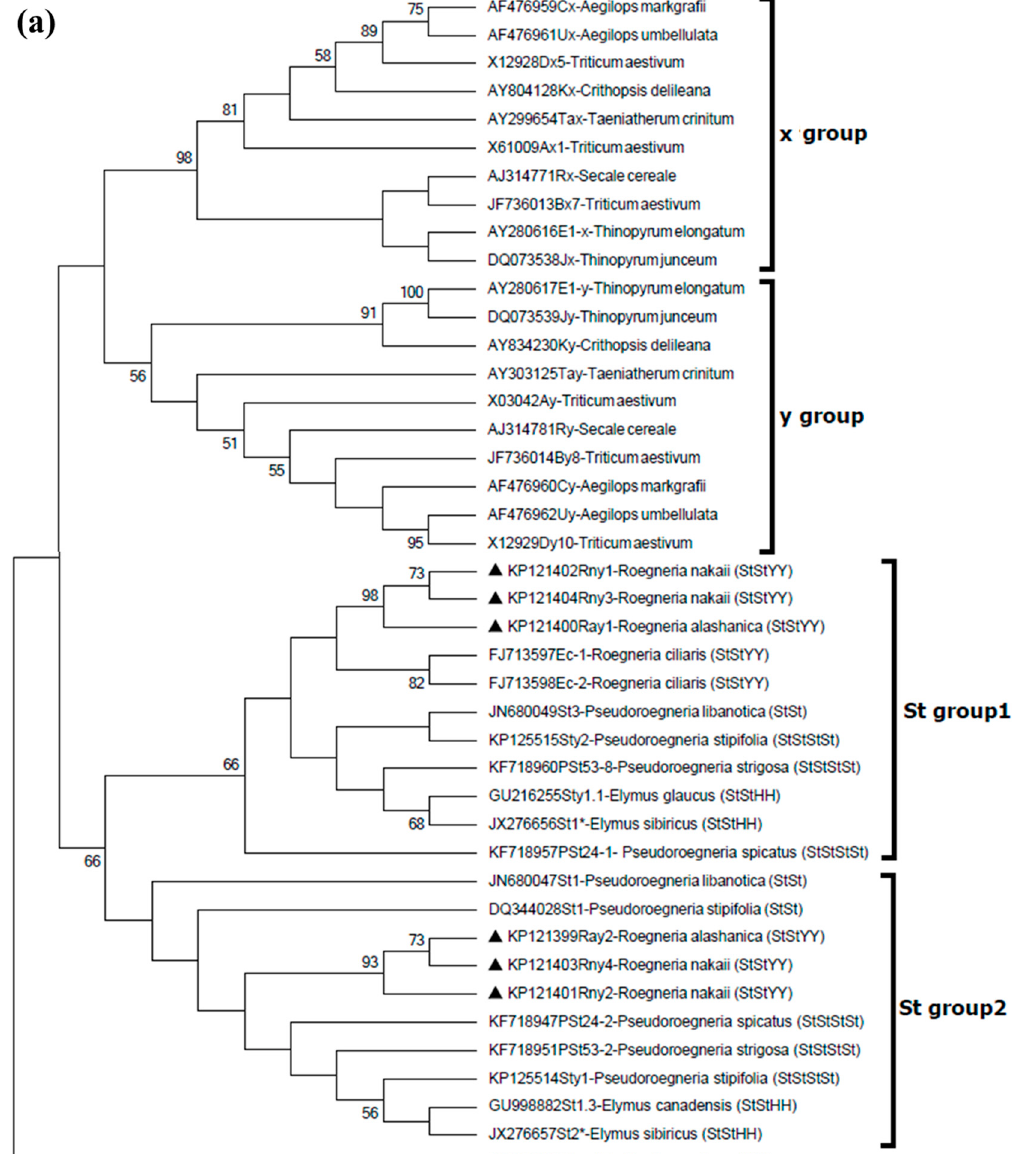
Figure 6. Figure 6. Cont.